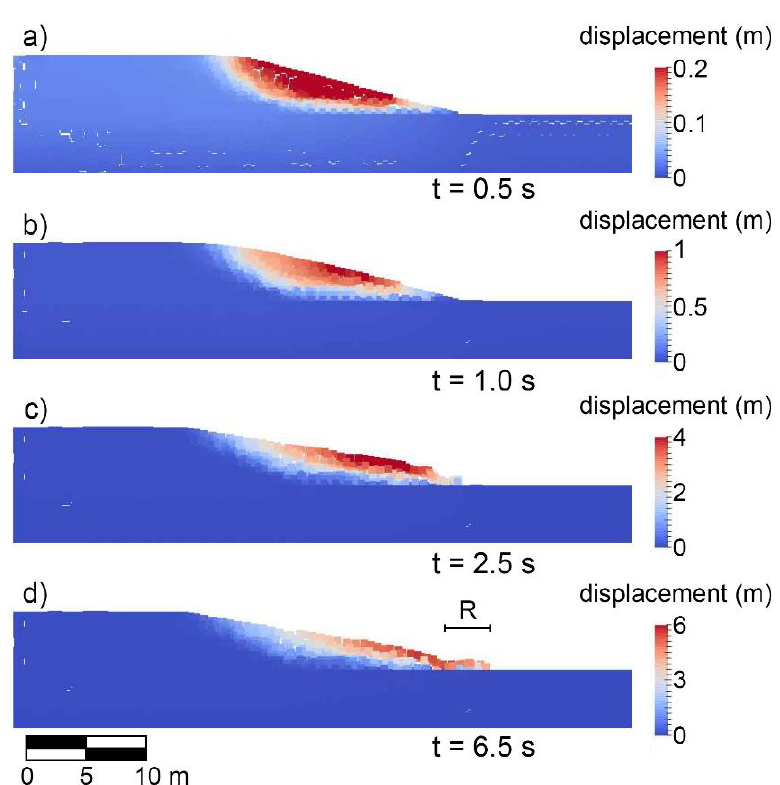
Figure 7. Total displacement of the material points at different times, for the case with: φ’ = 35°; α = = 15 ◦ ; H = 5 m, and ∆ u = 40 kPa. ( a ) t = 0.5 s; ( b ) t = 1.0 s; ( c ) t = 2.5 s; ( d ) t = 6.5 s. R: run-out 15°; H = 5 m, and Δu = 40 kPa. (a) t=0.5 s; (b) t=1.0 s; (c) t=2.5 s; (d) t=6.5 s. R: run-out distance. α